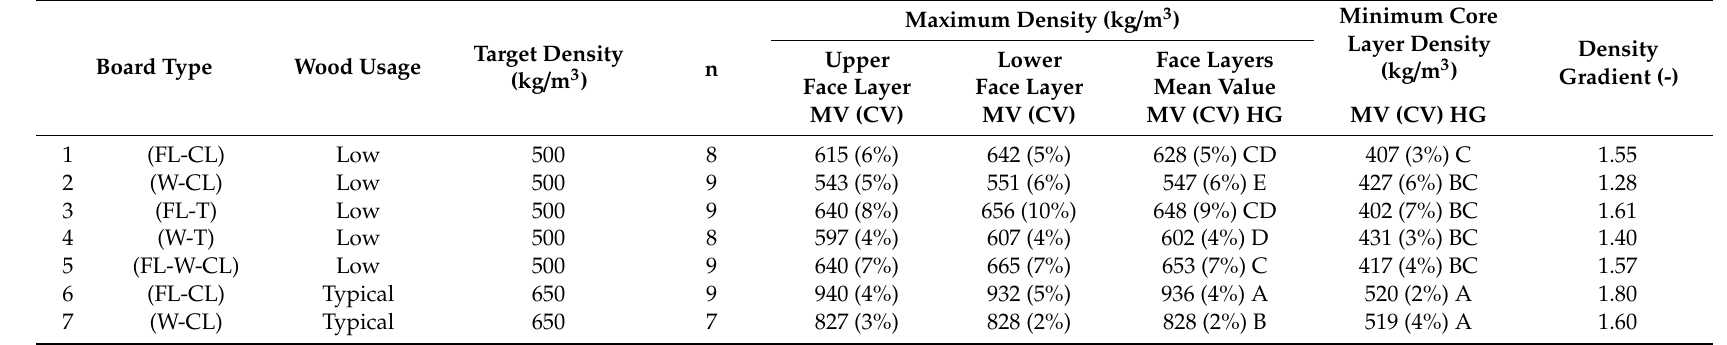
Table 7. Statistical characteristic values (MV, CV) of the radiometrically determined maximal face and minimal core layer sample density, results (HG, indicated by letters) of statistical mean value comparison, and specification of the density